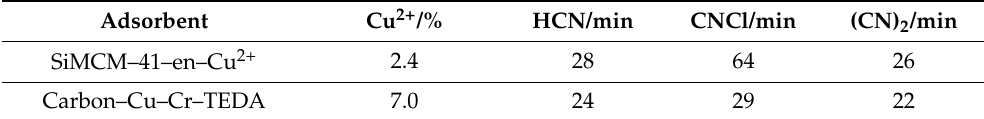
Table 3. Penetration time of HCN, CNCl, and (CN) 2 on MCM–41 and carbon-based adsorbent [51].